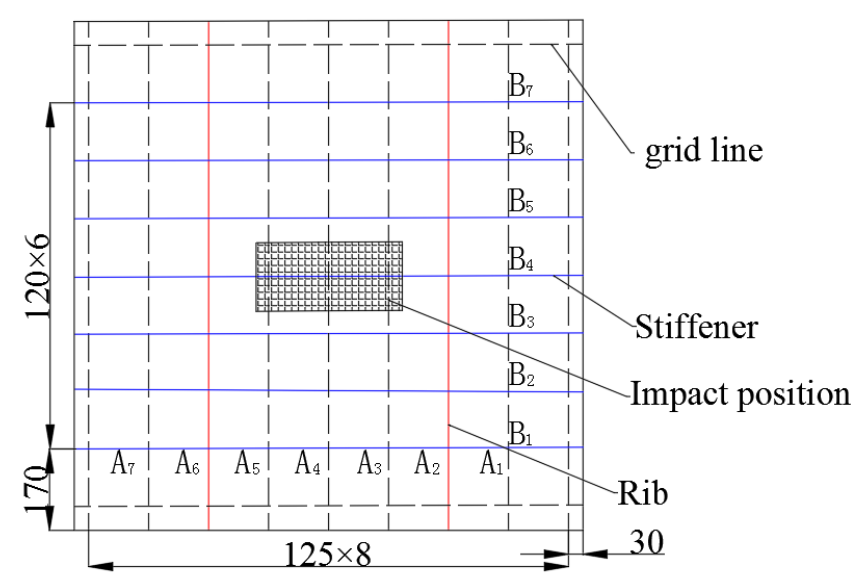
Figure 8. Schematic diagram of the layout of measurement points.